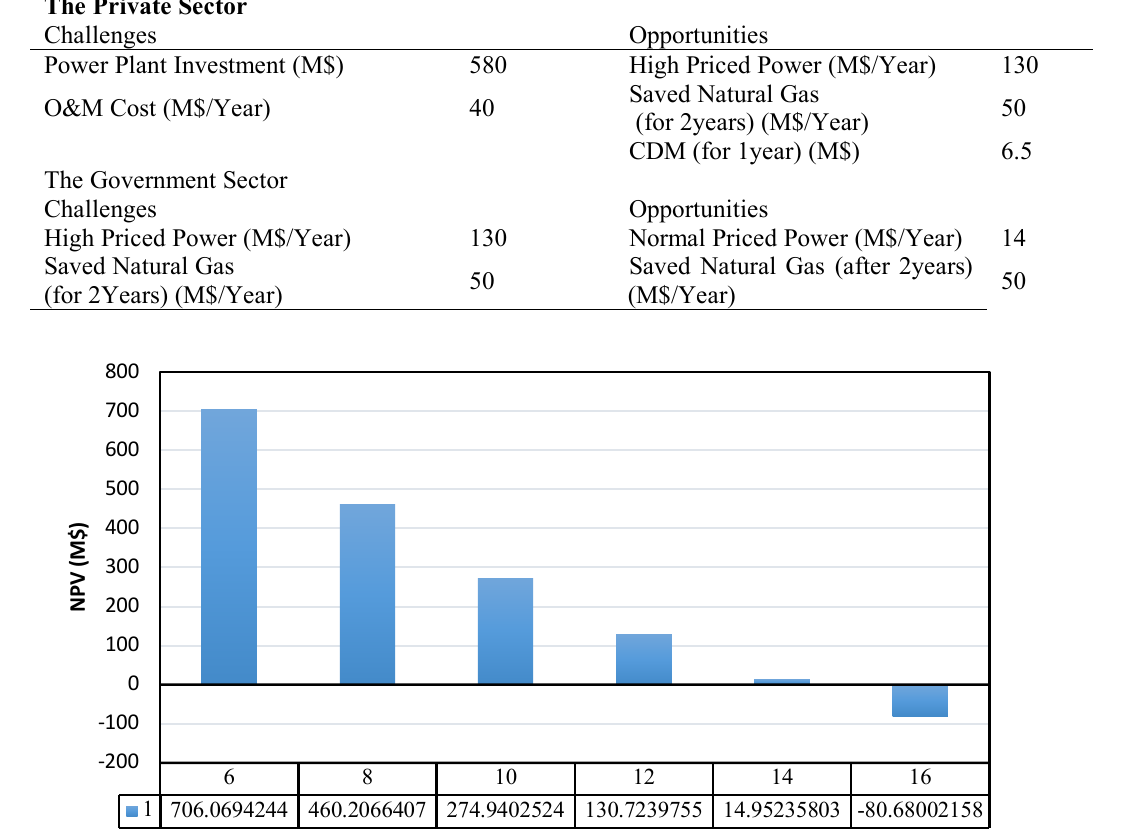
Figure 3. Net present value of project based on different interest